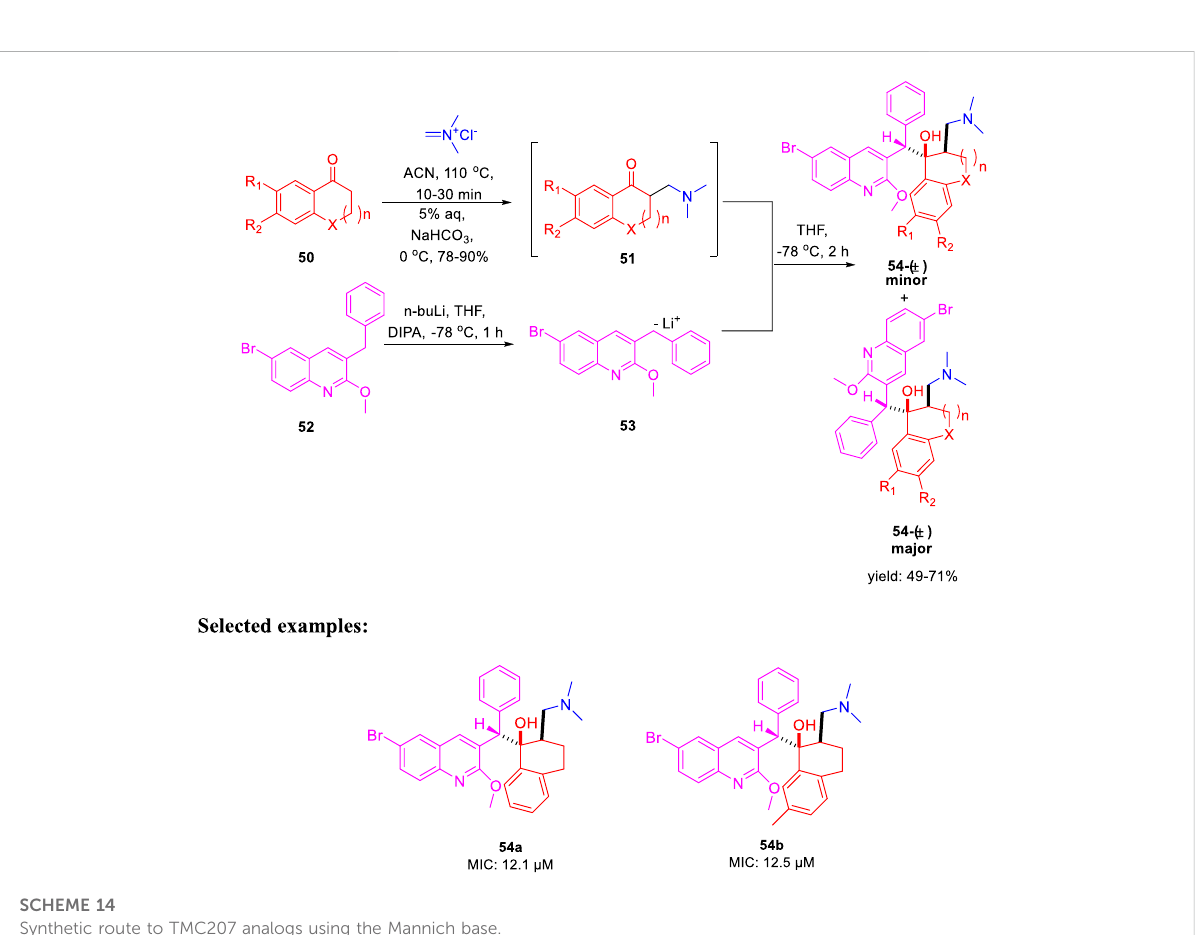
SCHEME 14 Synthetic route to TMC207 analogs using the Mannich